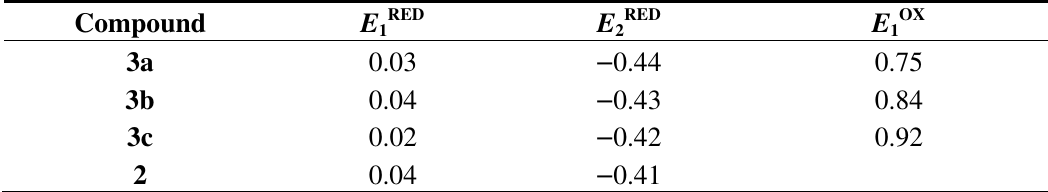
Table 1. CV data of TCNQ derivatives 3a – 3c and 2